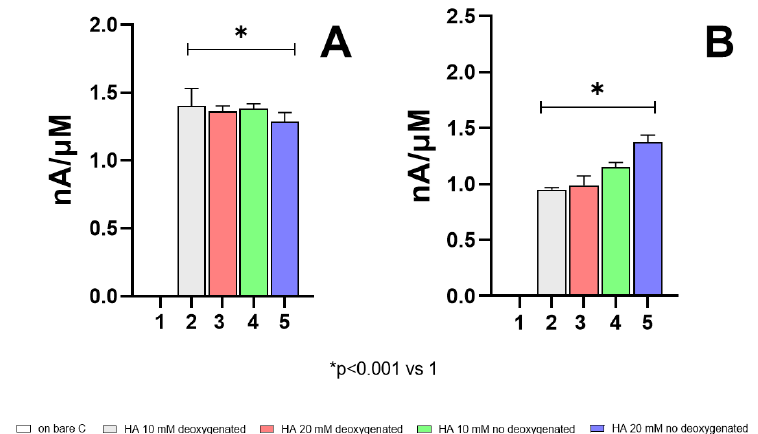
Figure 4. HP slopes, expressed as nA/ μ M ± SEM, obtained from 2 + 2 + 2 CV cycles (without HP and AA calibration between the series) (Panel ( A )) and CPA (Panel ( B )), both on CCRs, using